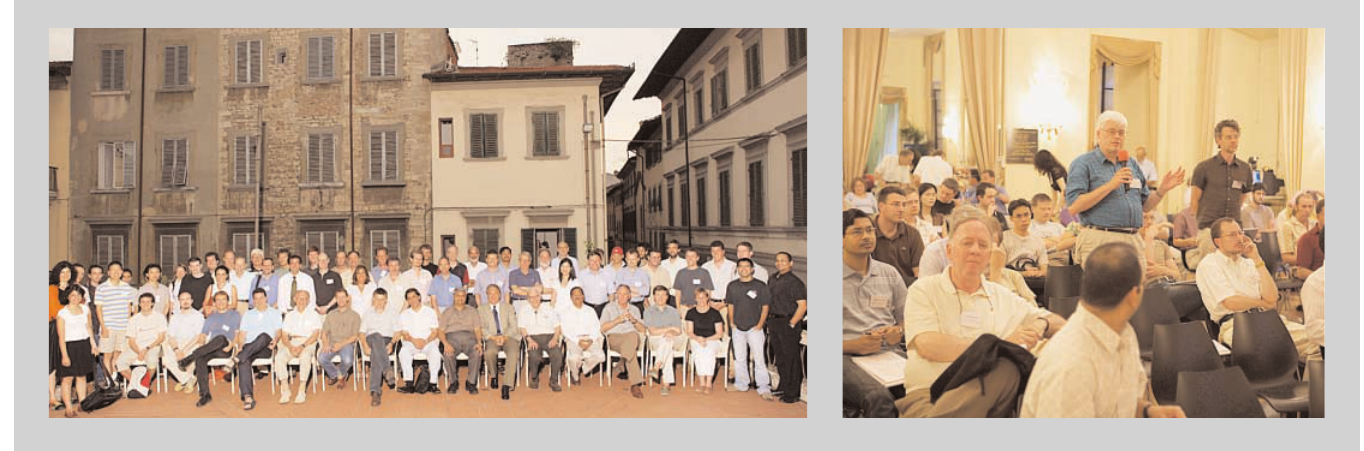
Figure 1 (left): Participants at the IWMMCOF ’06 in the terrace of the Pallazo Vaj Figure 2: Burkhard Dünweg (center) asks a question during the IWMMCOF ’06. Jay Schieber at right leads the